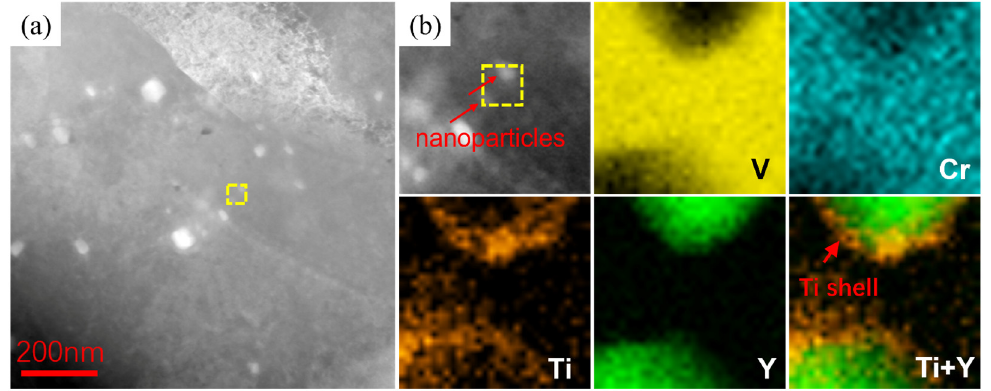
Figure 8. STEM images and corresponding EDS element distribution near nanoparticles in V-4Cr-4Ti-2Y alloy: ( a ) STEM image; ( b ) EDS element distribution of the yellow-boxed area.